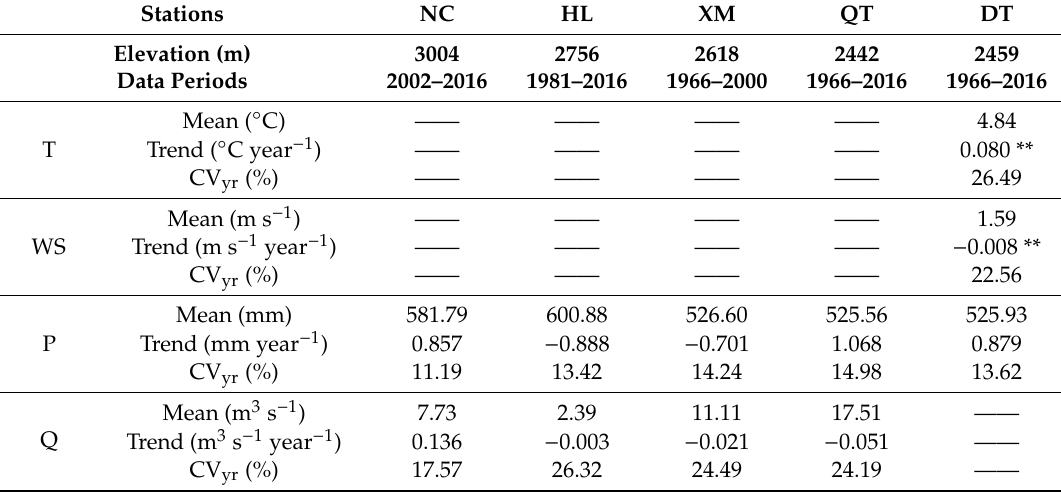
Table 1. Mean annual, annual trend, and variability of air temperature (T), wind speed (WS), precipitation (P), and streamflow (Q) calculated from daily time series observed at Niuchang